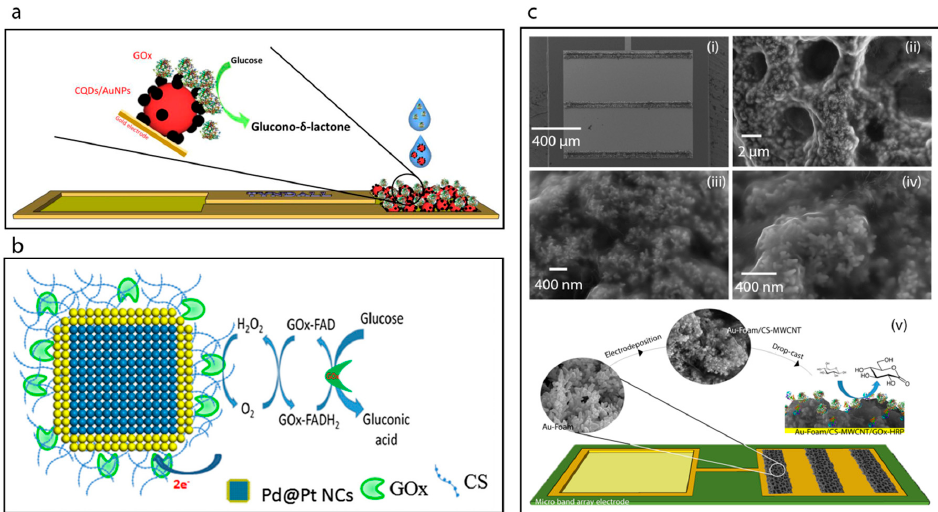
Figure 6. ( a ) Schematic image the construction of the CQDs/AuNPs-GOx biosensor [20]. ( b ) Schematic